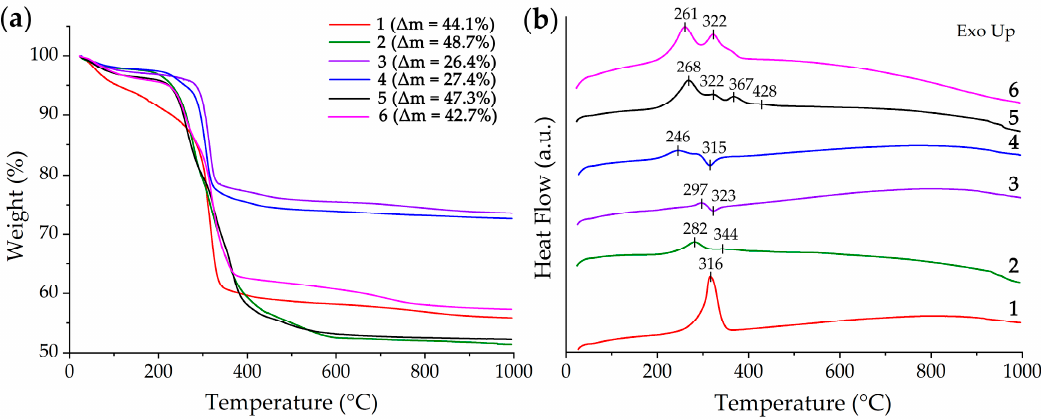
Figure 1. TGA ( a ) and DSC ( b ) curves of the obtained semi ‐ products after drying (100 °C, 3